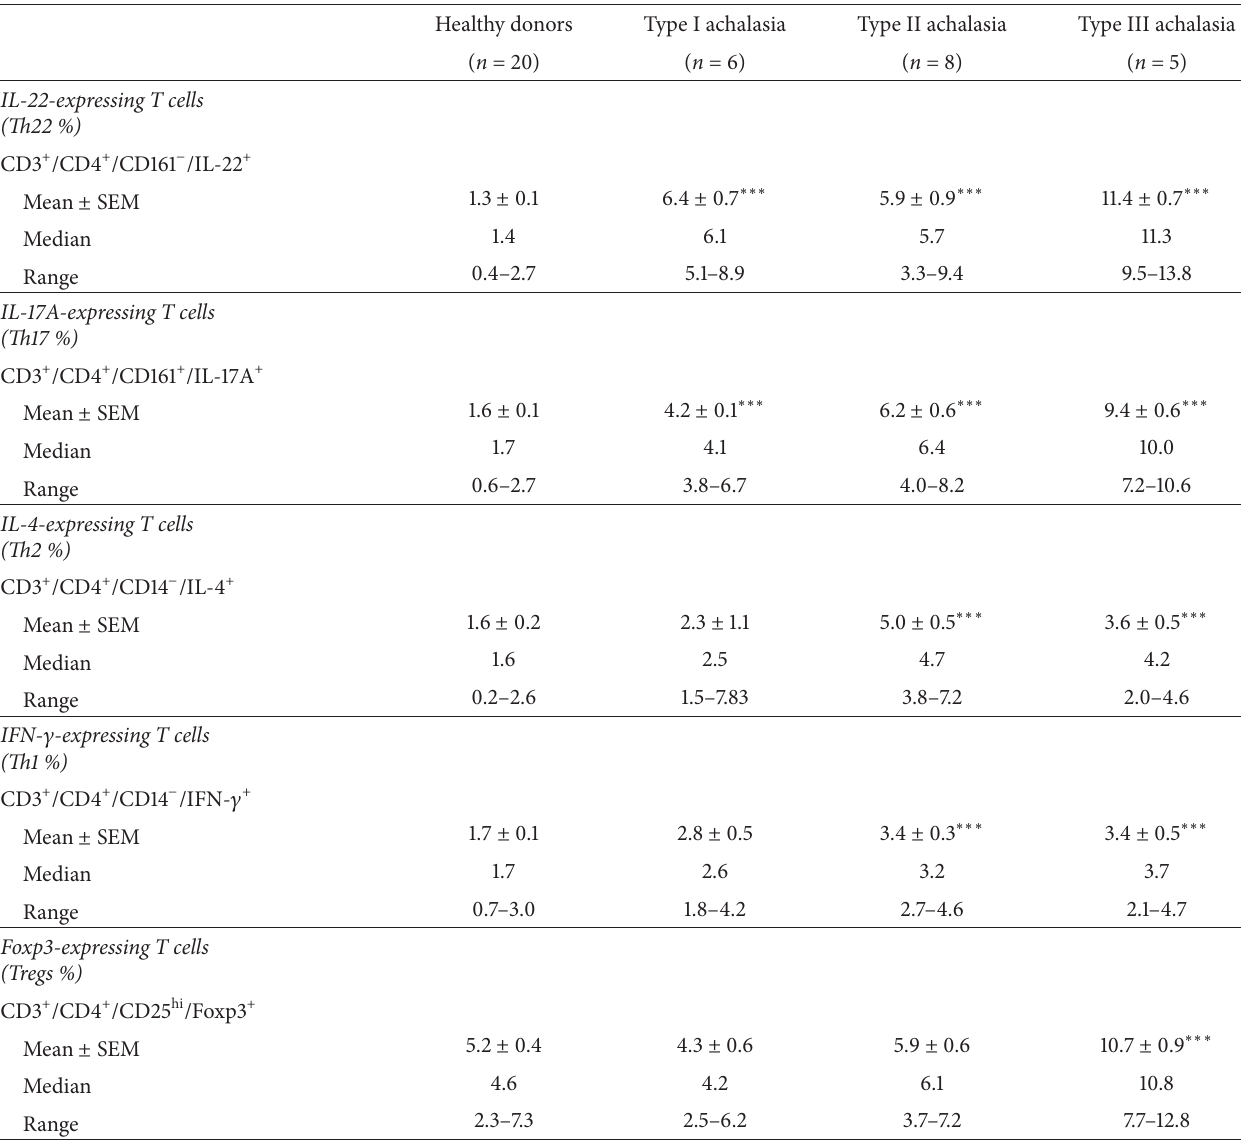
Table 3: Percentage of Th22-, Th17-, Th2-, Th1-, and Tregs-circulating cells in achalasia